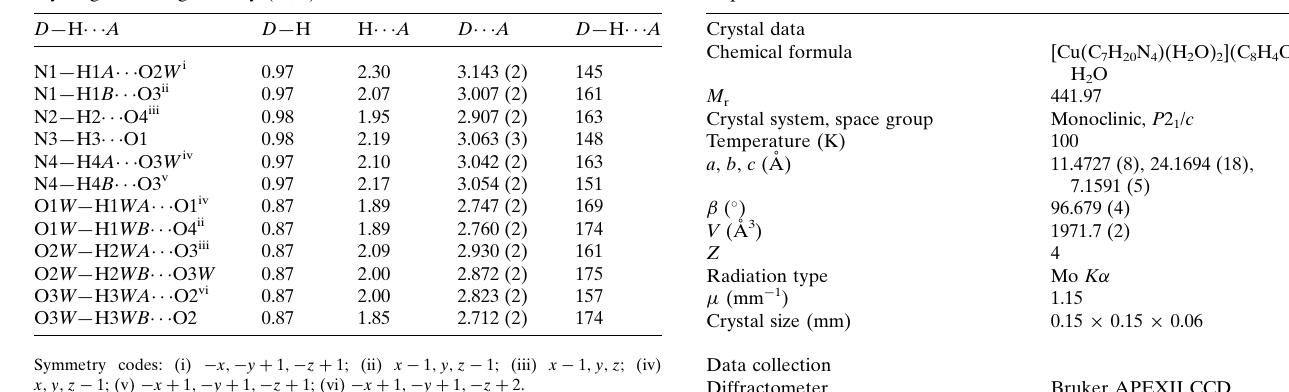
Table 2 Hydrogen-bond geometry (A˚ , (cid:5) ).